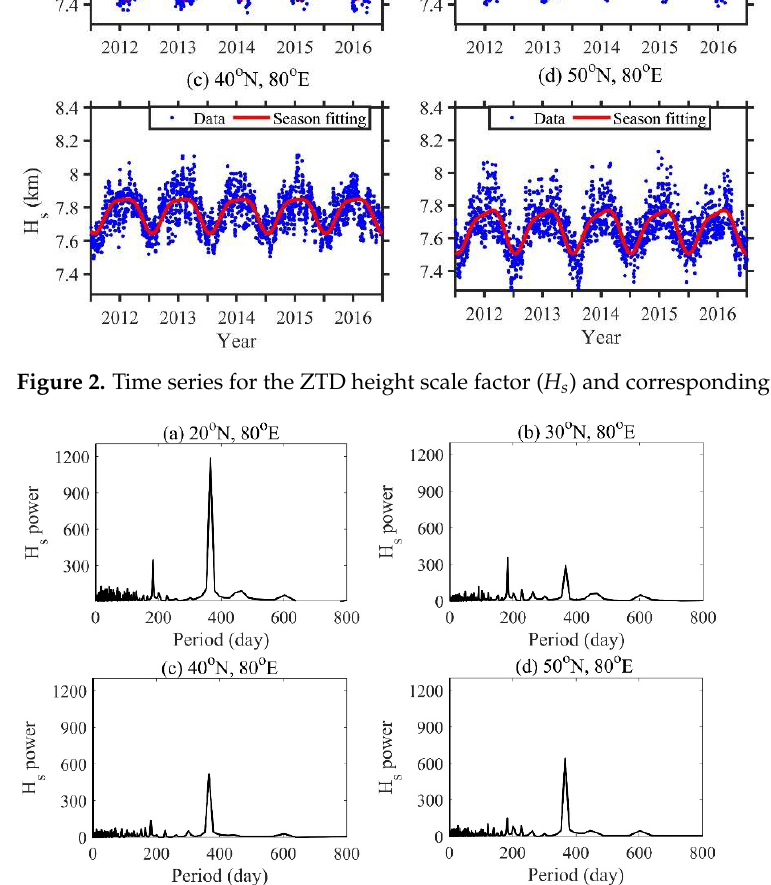
Figure 4. Distributions of the ZTD height scale factor: ( a , d ) annual mean (unit: mean value/km), ( b , e ) annual amplitude (unit: amplitude/km), and ( c , f ) semiannual amplitude (unit: amplitude/km). 3.2. Establishment of the CZTD-H Model The analysis presented in Section 3.1 indicates that (cid:1834) (cid:3046) shows important spatial-tem- poral characteristics in China; thus, the fine spatial-temporal variation in (cid:1834) (cid:3046) should be considered in a model. A grid with the same horizontal resolution as the reanalysis data was selected to develop the ZTD vertical profile grid model with a high horizontal reso- lution. For each grid point (15–55° N, 70–135° E) covering China, the ZTD vertical profile model can be expressed as follows: (cid:1852)(cid:1846)(cid:1830) (cid:3047) = (cid:1852)(cid:1846)(cid:1830) (cid:3045) ∙ exp (− (cid:1834) (cid:3047) − (cid:1834) (cid:3045) (cid:1834) (cid:3046)(cid:3036)